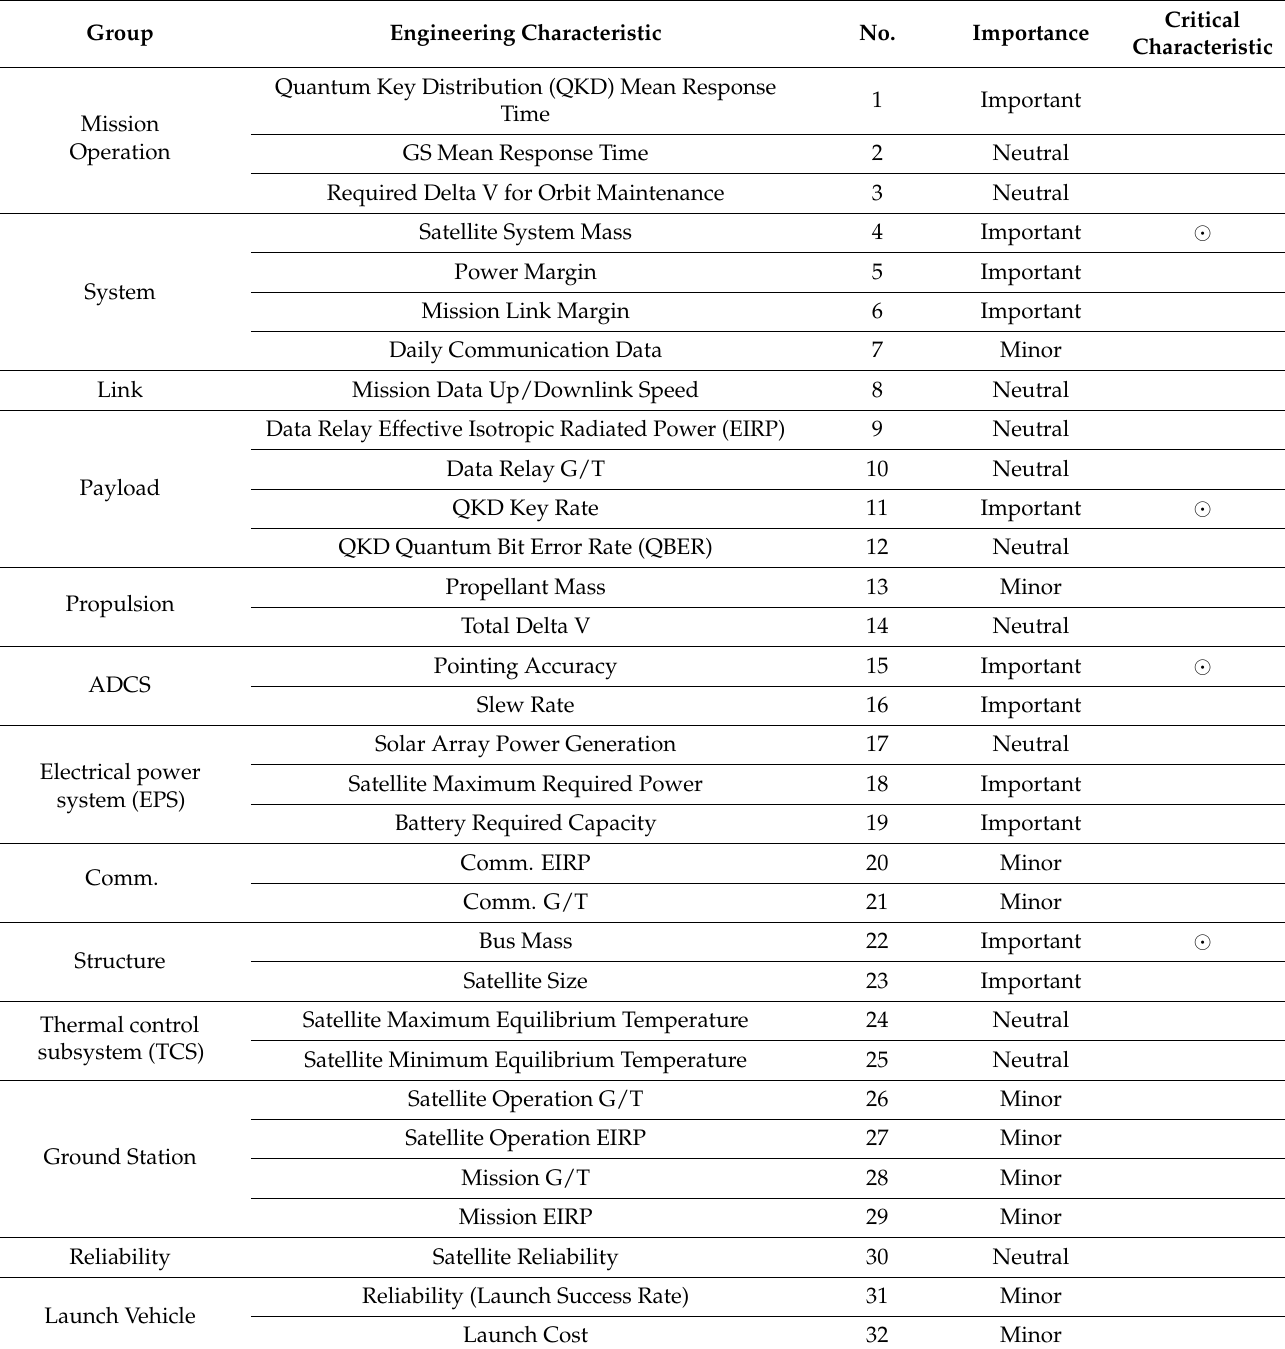
Table 3. Engineering characteristics